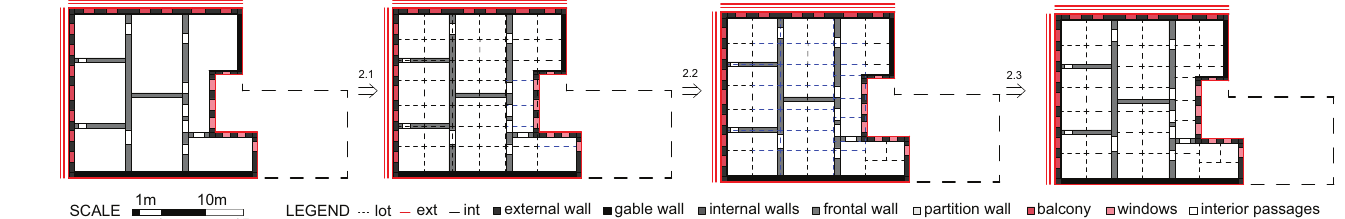
Figure 8. Derivation process considering steps for stage 2 for the case study building